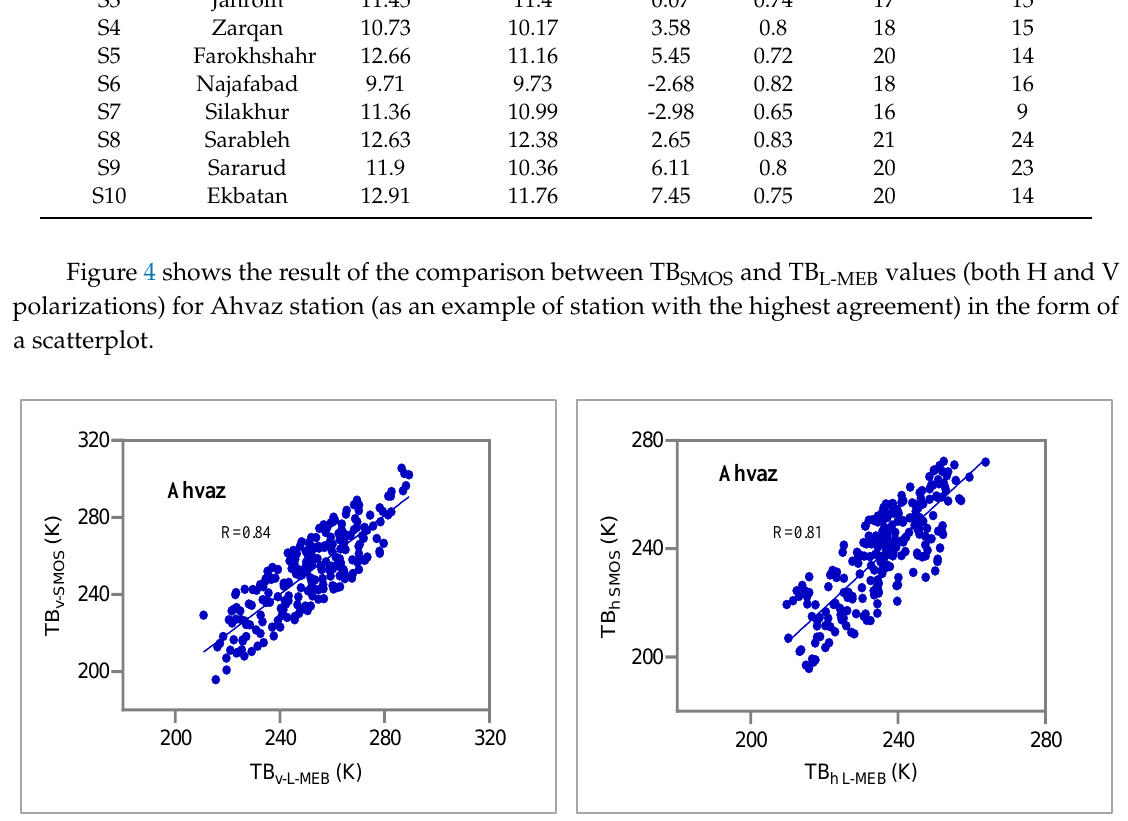
Figure 4. The scatterplots of the TB SMOS against the TB L-MEB for Ahvaz station. The left plot for H polarization and right plot for V polarization.